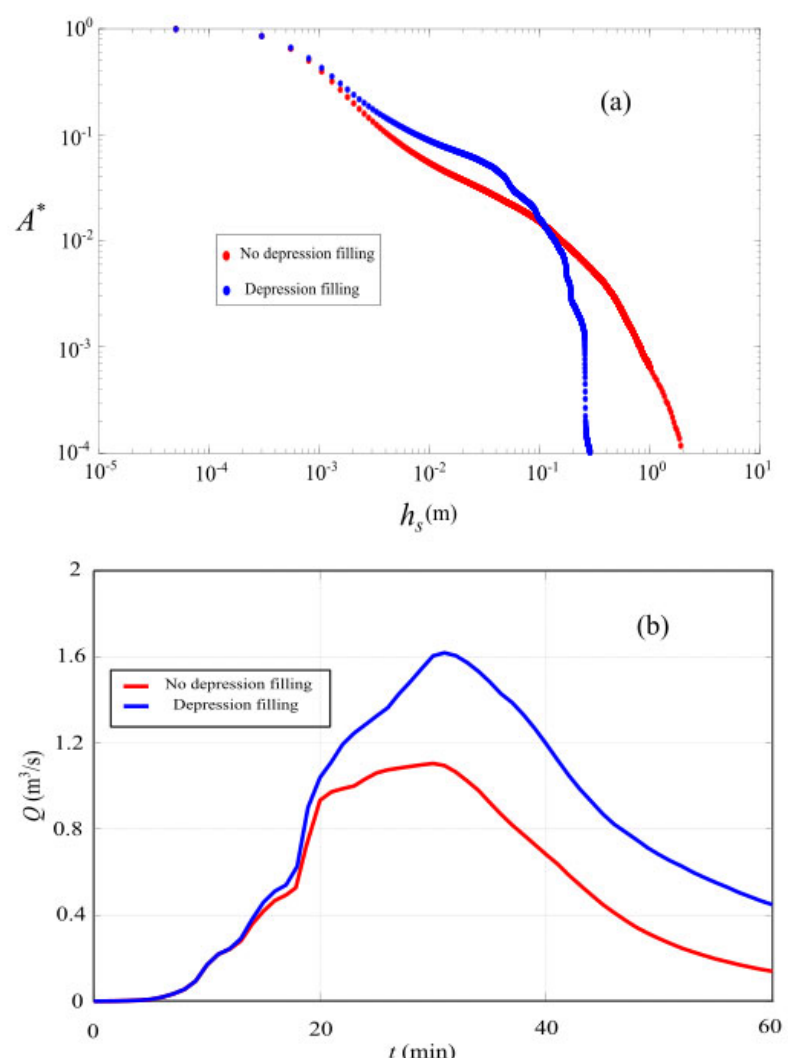
Figure 11. RC2 watershed: effects of the DEM filling on the river drainage patterns tracked by the rain-on-grid approach using the scaling laws criteria ( a ) and on the simulated discharges ( b .